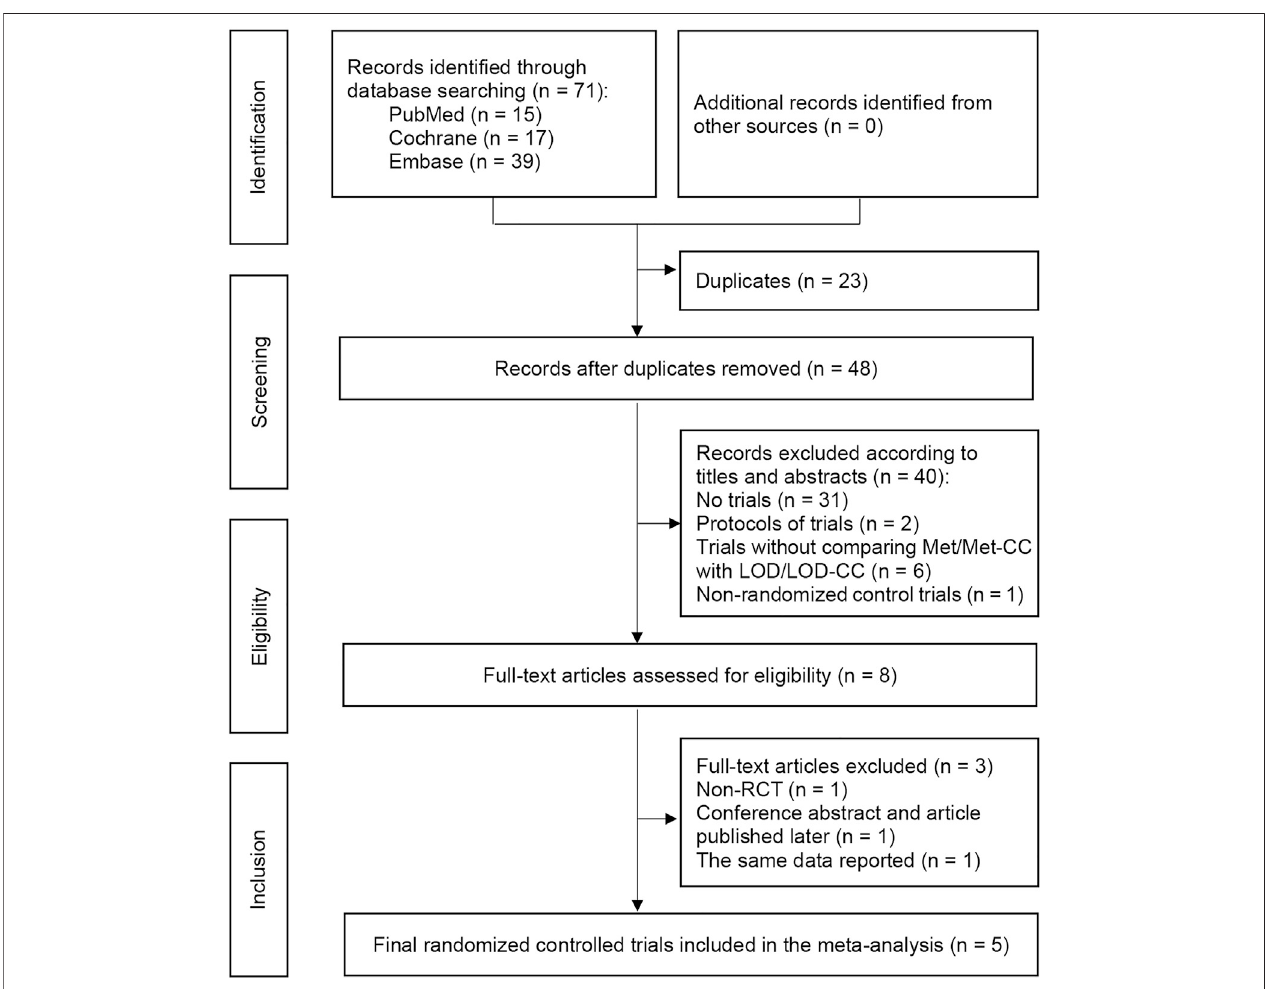
FIGURE1 | Preferred Reporting Itemsfor Systematic Reviews and Meta-analyses fl owchart depicting theprocess of paperselectionand thenumber ofpapers in each phase. Notes: RCT, randomized controlled trial.